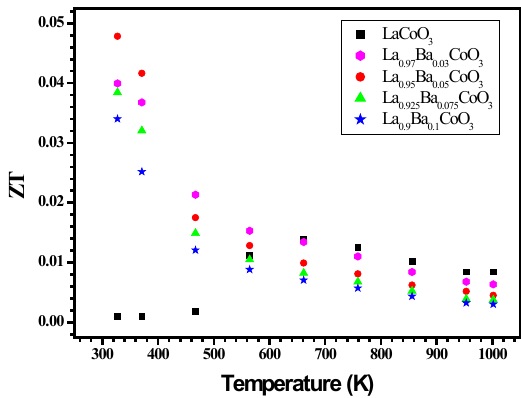
Fig. 8 Temperature dependence of the ZT value of the La 1 − x Ba x CoO 3 sample with x = 0, 0.03, 0.05, 0.075, and